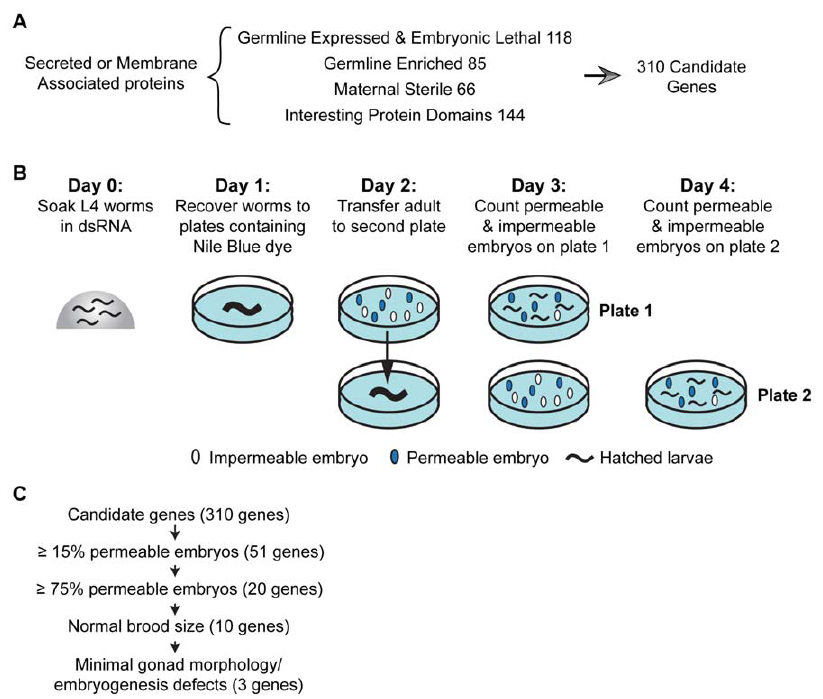
Figure 1. A screen for genes required for eggshell impermeability. A. Since the eggshell is a secreted structure, all candidate genes encoded proteins with a signal peptide or a membrane-targeting domain. Our candidate gene set included all of the germline enriched ([13,14]) and maternal sterile ([5]) genes that have a signal peptide. Since the set of genes expressed in dissected germlines that have a signal peptide is large (1137 genes, Serial Analysis of Gene Expression database, Genome BC C. elegans Gene Expression Consortium, http://elegans.bcgsc.bc.ca) we included only those previously shown to result in embryonic lethality when inhibited by RNAi (Wormbase release WS199). Genes with proteins domains (chitin binding, glycosylation, protease, peroxidase, lipid binding, or LDLR domains) found in proteins implicated in eggshell formation or analogous processes in other species were included regardless of whether there was prior evidence for a germline role. Due to redundancy, the total number of candidate genes was 310. B. Outline of screen to identify genes specifically required for eggshell impermeability. C. Of the 310 candidate genes tested, 3 genes were identified whose inhibition permeabilized the eggshell with high penetrance ( . 75% permeable embryos), while maintaining a normal broodsize and leading to minimal defects in gonad structure/embryonic development. One of these genes, perm-1 , was chosen for